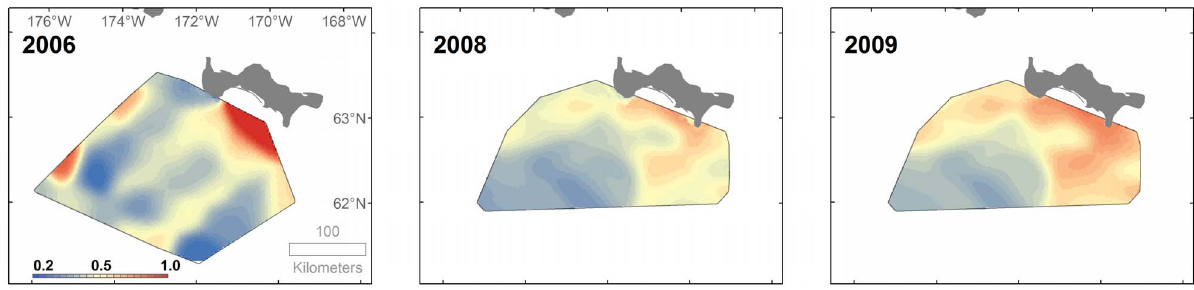
Figure 6. Average probability of walrus resource selection within benthic sampling areas in 2006 and 2008–2009.